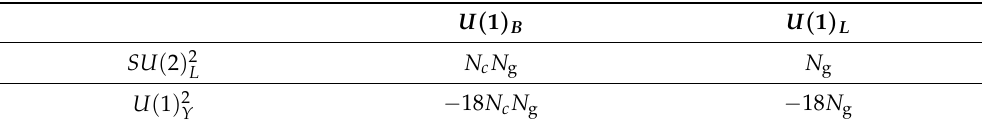
Table 2. Mixed anomalies of the classical accidental symmetries with the chiral gauge symmetries of the SM. N c is the number of colors, and N g is the number of